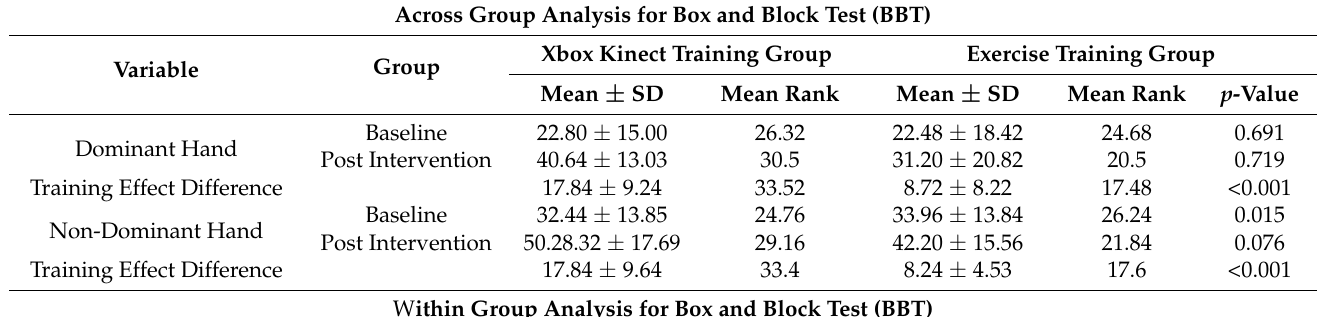
Table 4. Within- and across-group analysis for dominant and non-dominant hand utilizing the Box and Block Test. Across Group Analysis for Box and Block Test